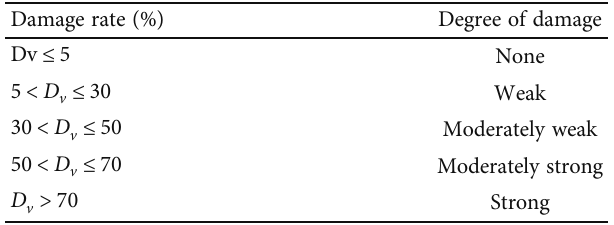
Table 4: Evaluation index of damage